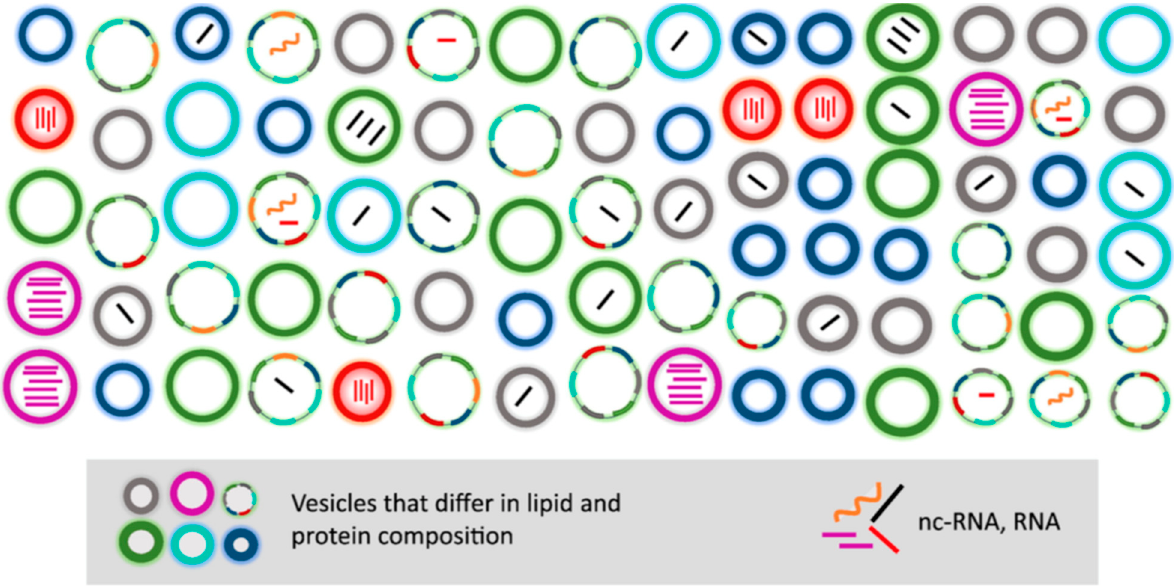
Figure 4. Proposed model of heterogeneous exosomal composition and subpopulations. Different subspecies exist within exosomes isolated from the same batch of cells. Exosomes can differ with regard to lipid, protein, and miRNA composition. “Potent” exosomal subspecies enriched with a high number of miRNA (depicted as purple and red vesicles) exist next to exosomes that are essentially devoid of nucleic acids. Reprinted with permission from Reference [54].